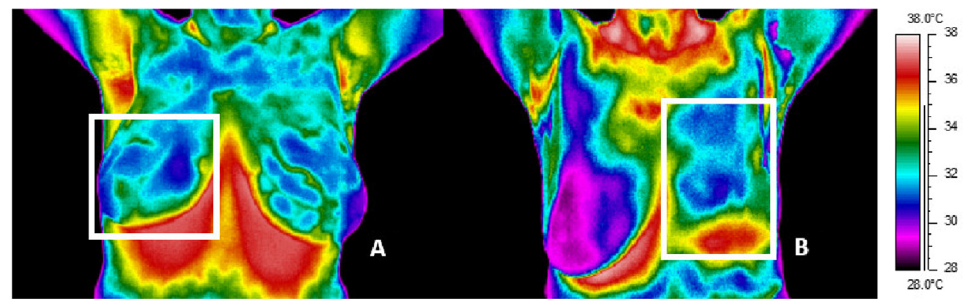
Figure 3. Thermal image of representative patient after surgery ( A ) and mastectomy ( B ) taken over